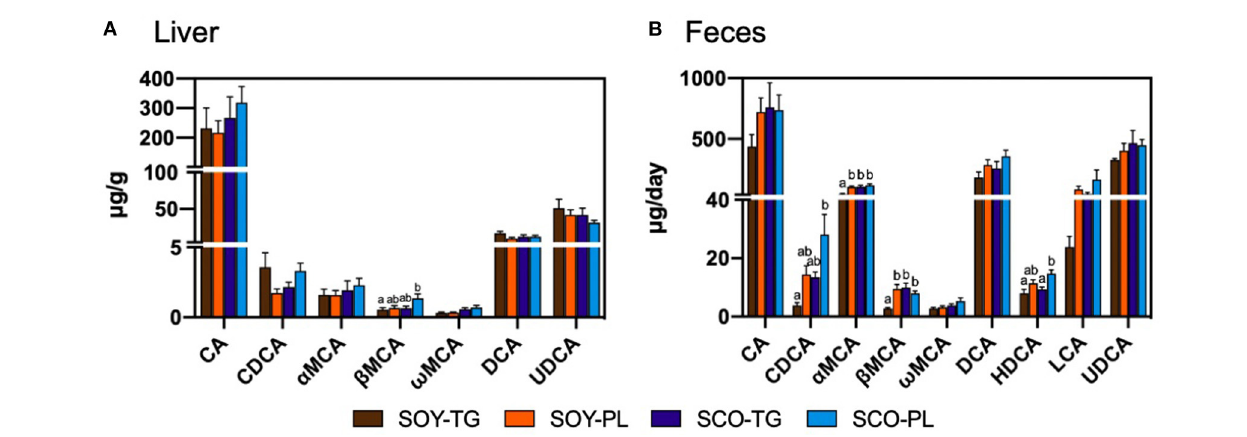
FIGURE 1 | Bile acids composition in the liver (A) and feces (B) . Data represent the mean ± SEM ( n = 8). Different letters indicate significantly different at p < 0.05 (Tukey’s multiple comparison test). CA, cholic acid; CDCA, chenodeoxycholic acid; DCA, deoxycholic acid; HDCA, hyodeoxycholic acid; LCA, lithocholic acid; α MCA, α -muricholic acid; β MCA, β -muricholic acid; ω MCA, ω -muricholic acid; SCO-PL, scallop oil’s phospholipids fraction; SCO-TG, scallop oil’s triglyceride fraction; SOY-PL, soybean oil’s phospholipids fraction; SOY-TG, soybean oil; UDCA, ursodeoxycholic acid.